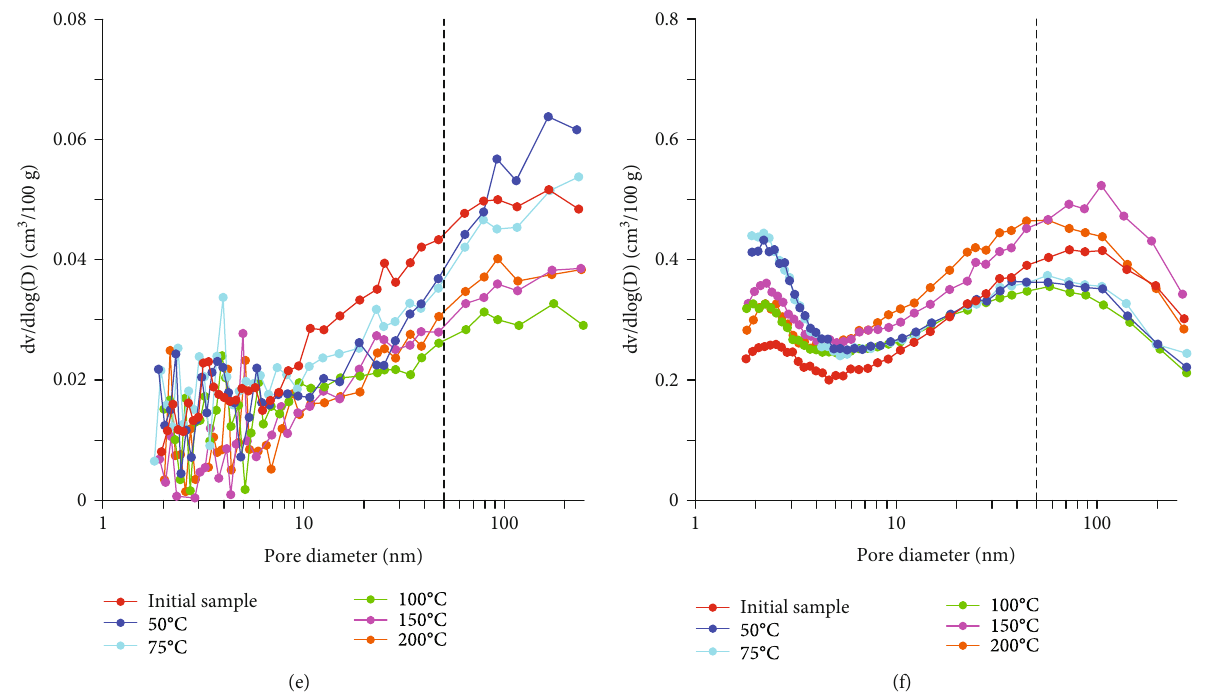
Figure 7: N adsorption isotherms for initial and altered rock grains ((a) limestone series, (b) dolostone series, and (c) sandstone series) and 2 pore volume distribution with pore size derived from N adsorption isotherms using the BJH model ((d) limestone series, (e) dolostone series, 2 and (f) sandstone series). Dotted lines in 7(d) and 7(f) di ff erentiate macropores ( > 50 nm) and mesopores (2 – 50nm). Note that numerical scales di ff er among the y